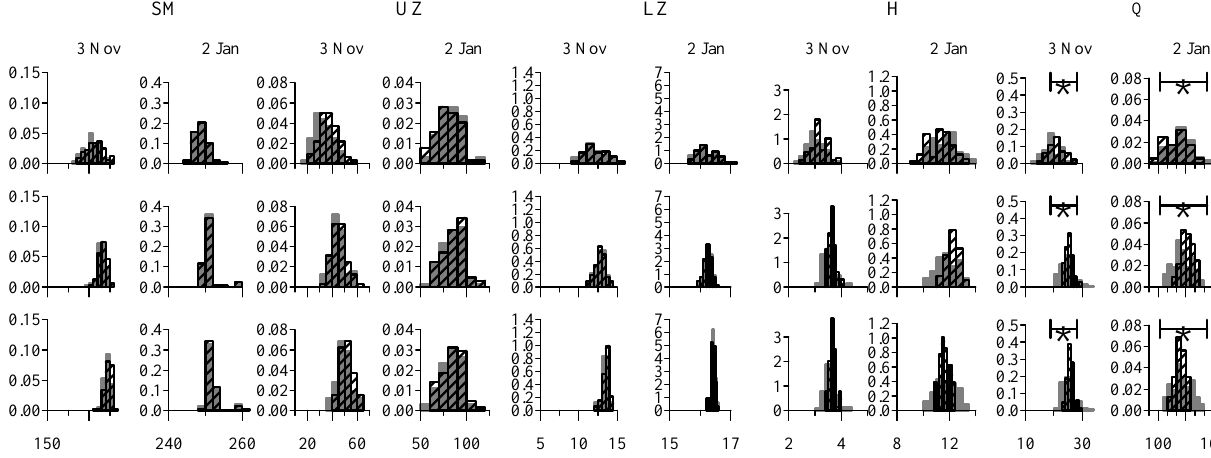
Fig. 11. Same as Fig. 10, but for location